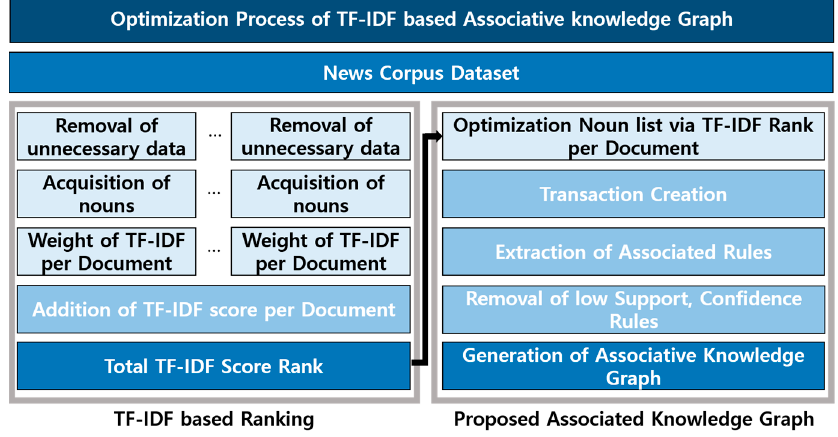
Figure 7. Optimization Process of TF-IDF based Associative Knowledge Graph.